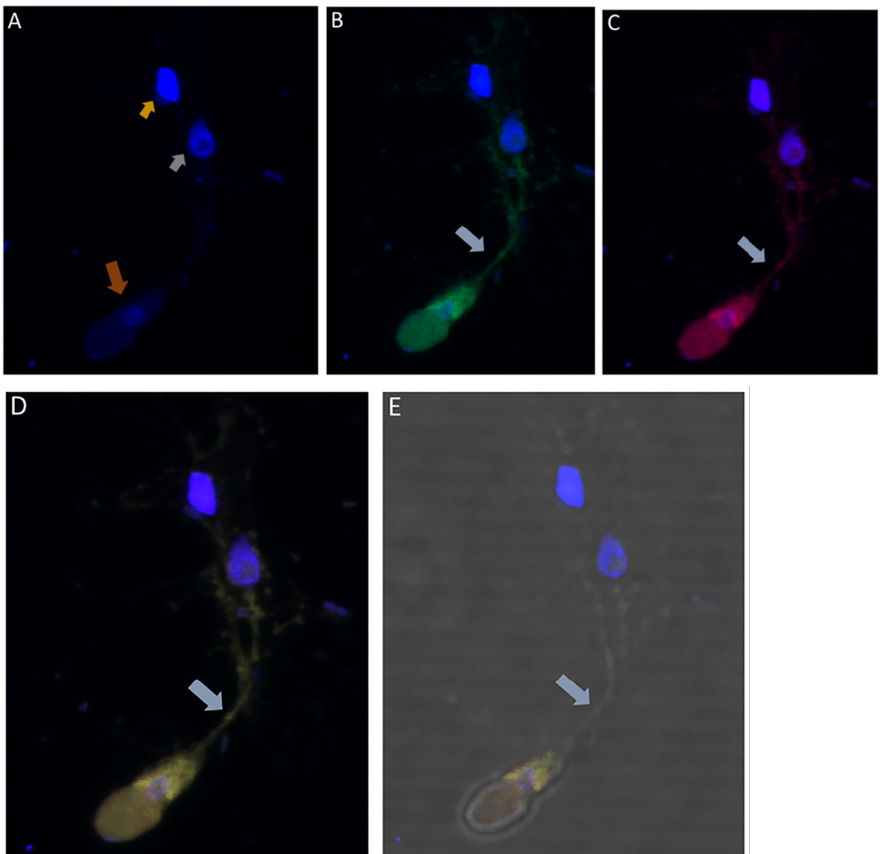
Figure 7. ( A – E ): Immunofluorescence microscopy of Colpodella sp. (ATCC 50594) trophozoite in myzocytosis using antiserum 686 (1:100 dilution) specific for P. falciparum rhoptry protein, RhopH3 (green) and antiserum FL (1:100 dilution) specific for P. berghei RhopH3 (red). DAPI and DIC images are also shown. ( A ). DAPI staining showing nucleus of Colpodella sp. trophozoite (red arrow), nucleus (grey arrowhead) and kinetoplast (gold arrowhead) of P. caudatus trophozoite. ( B ). Antiserum 686 cross reacted with Colpodella sp. (ATCC 50594) proteins in the cytoplasm and in the tubular tether used for attachment with the prey. ( C ). Antiserum FL cross reacted with Colpodella sp. (ATCC 50594) proteins in the cytoplasm and in the tubular tether used for attachment with the prey and is colocalized with antiserum 686. ( D ). merge of DAPI, 686 and FL showing antibody colocalization of antibody reactivity. ( E ). merge of DAPI, 686, FL and DIC showing antibody reactivity and morphology of Colpodella sp. (ATCC 50594) and P. caudatus trophozoites in myzocytosis. Antibody reactivity is seen on the tubular tether and within the P. caudatus prey in the section closest to the predator (movie in Supplementary Figure S2).